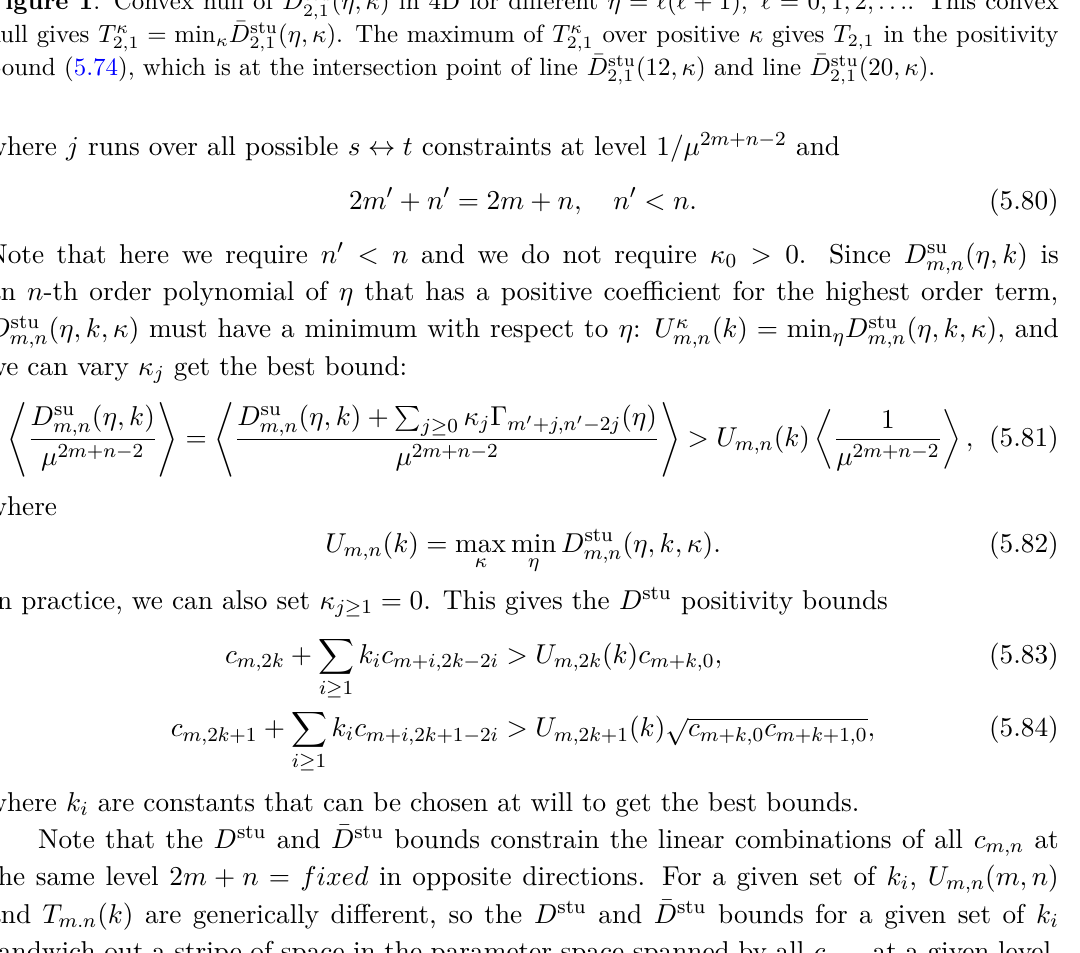
over positive κ gives T 2 , 1 (12 , κ ) and line ¯ D stu 2 , 1